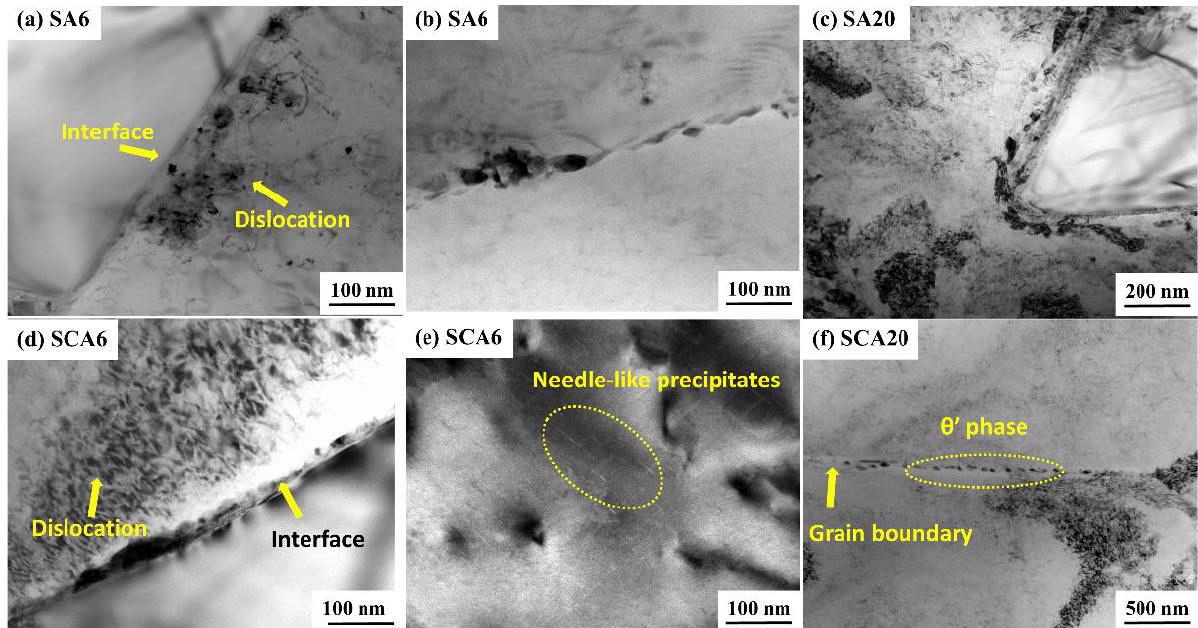
Figure 11. TEM micrographs of the 15%SiCp/2009Al composites treated by different processes: ( a , b ) SA6; ( c ) SA20; ( d , e ) SCA6; and ( f ) SCA20.